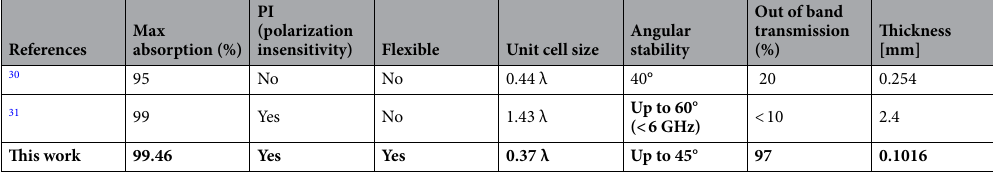
Table 1. Comparison with the